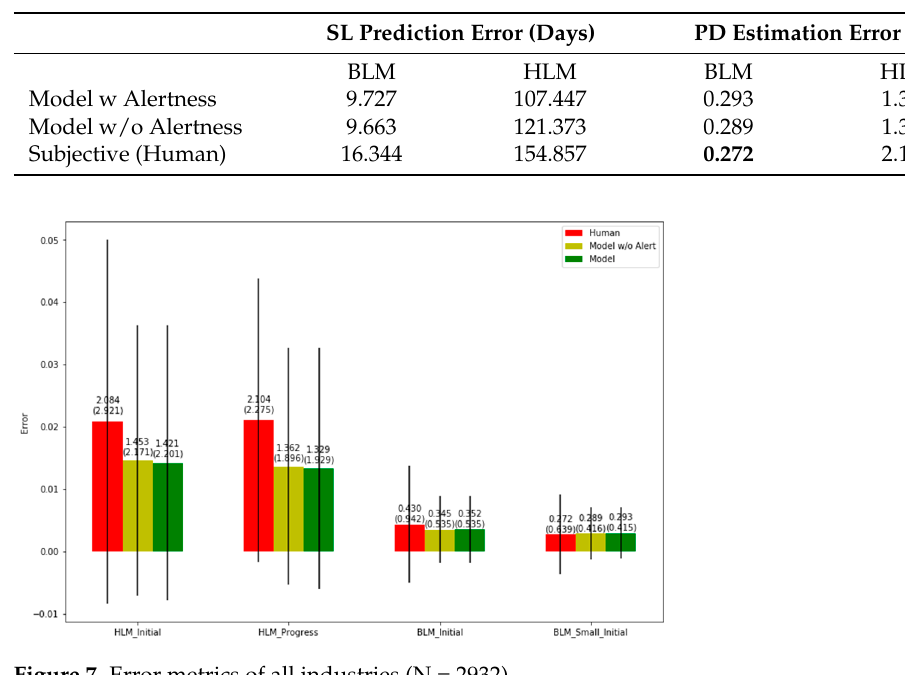
Table 3. Results comparison.